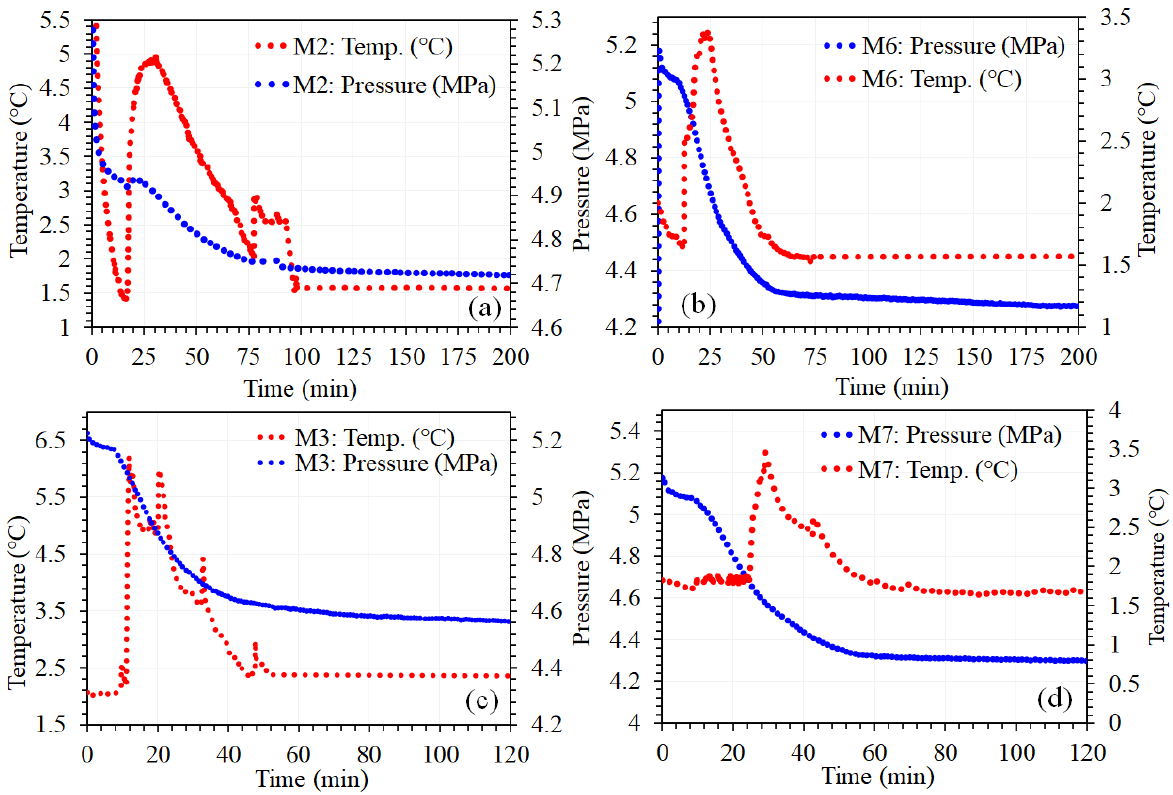
Figure 3. Comparison of temperature and pressure profile kinetic measurement of CH₄/DIW/IP ( a ) vs. CH₄/SW/IP ( b ) and CH₄/DIW/ SDS ( c ) vs. CH₄/SW/SDS ( d ).